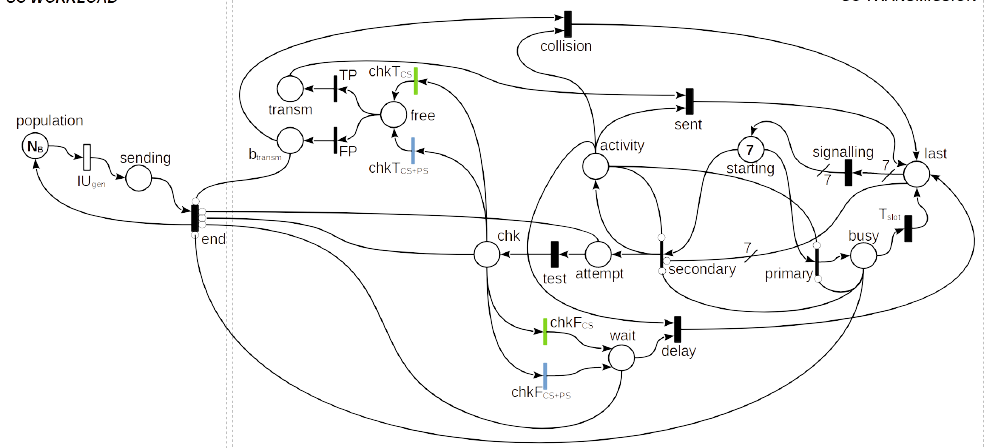
Figure 5. The SU model : secondary user performance